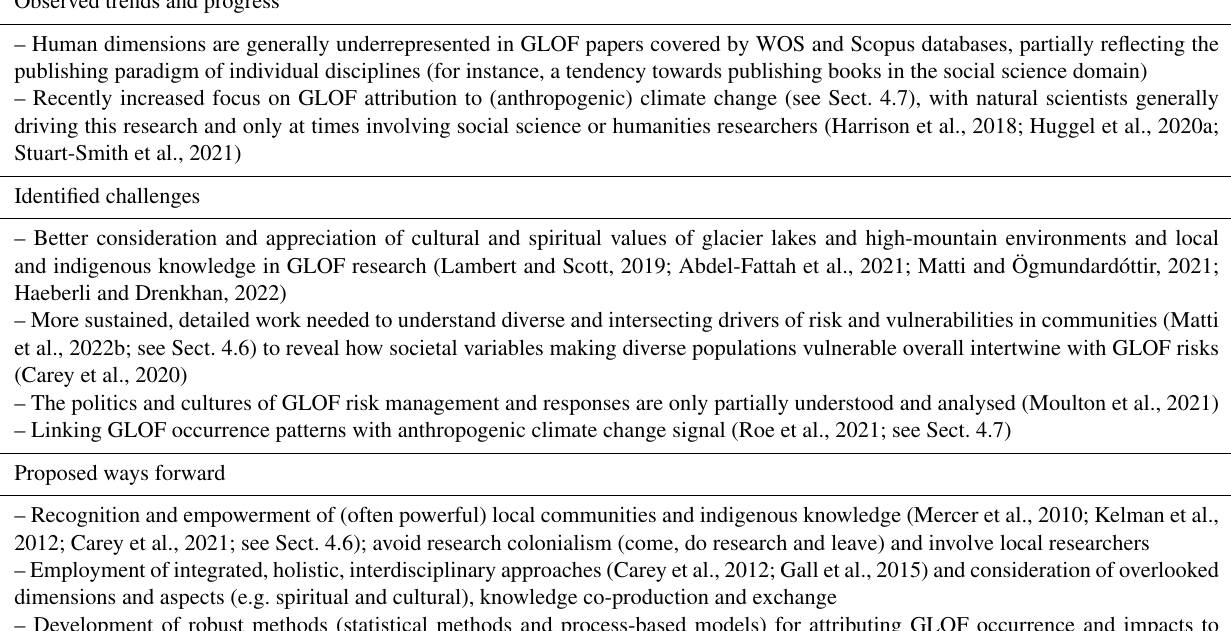
Table 4. Summary of the key topics, observed trends, identified challenges and proposed ways forward in the thematic area human dimensions of GLOFs and attribution to anthropogenic climate